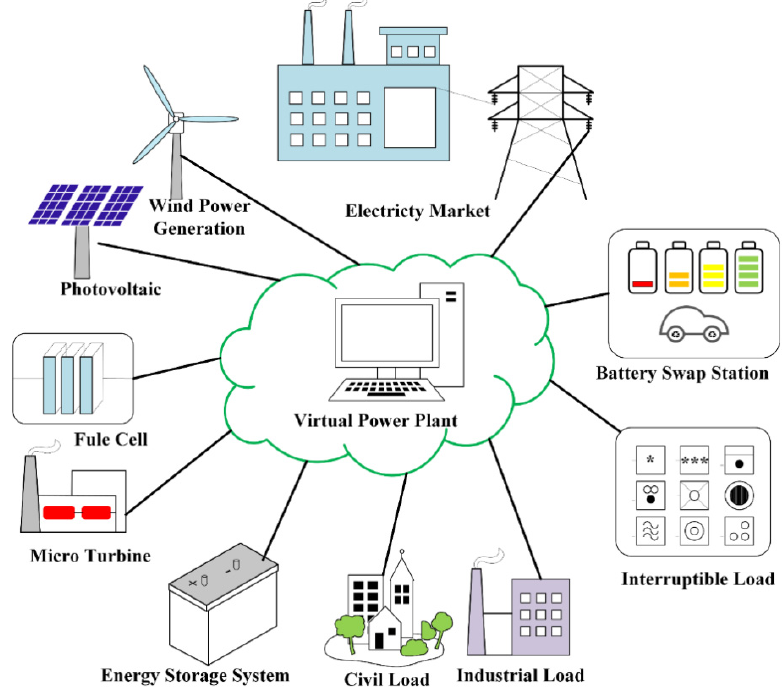
Figure 1. Basic elements in a Virtual Power